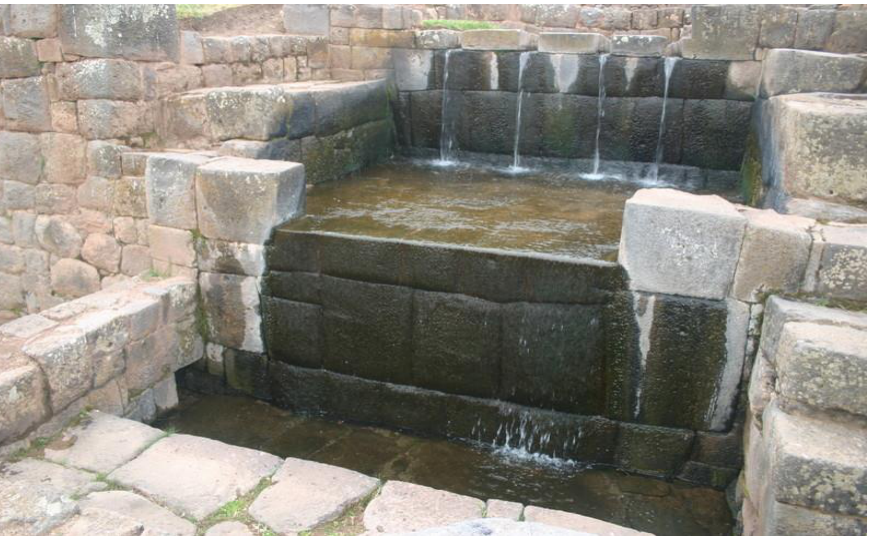
Figure 10. Waterfall display sourced by upper platform seepage water, several auxiliary channel water supplies and a spring source [5]. This structure is associated with platform 10 as described in the text and located in the terrace system shown in Figure 1. (Photo by C. Ortloff)